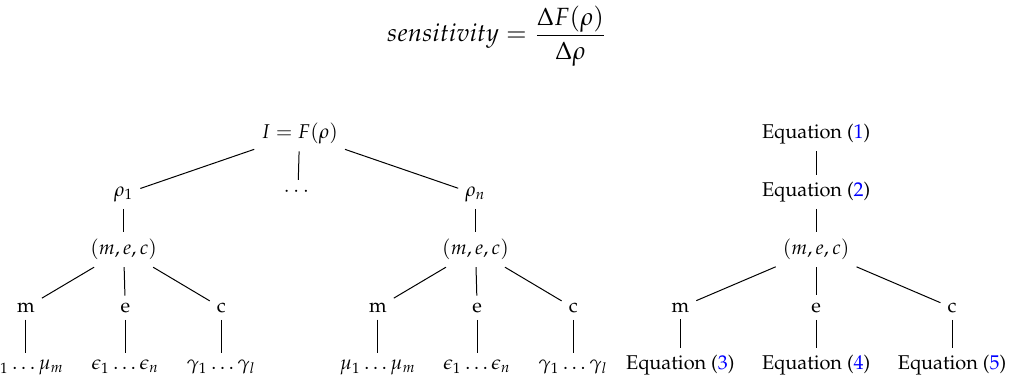
Diagram 1: Levels of magnitudes involved in the formation of the image. The image function as the most abstract level on the top, then each scene magnitude, the three elements that composes ρ , and the individual measurements of each element on the bottom of the tree.